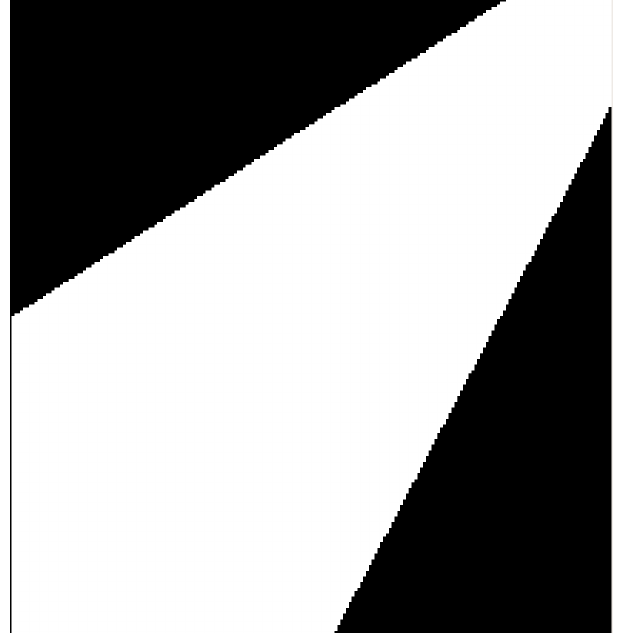
Figure 17. Predetermined mask shape.